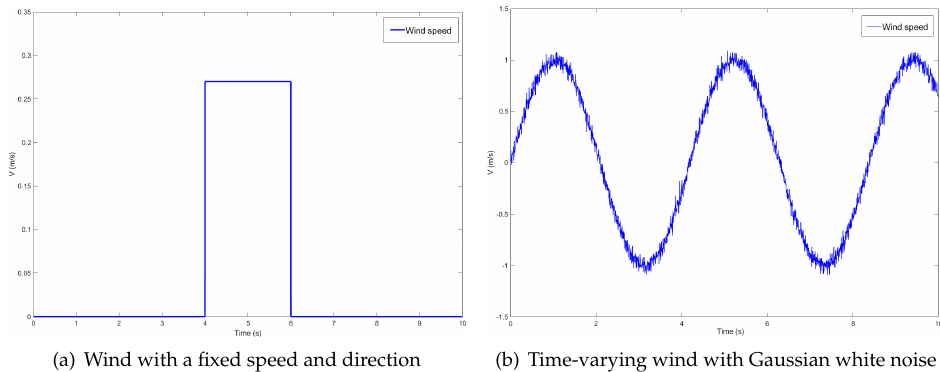
Figure 13. Two different types of disturbance signals.